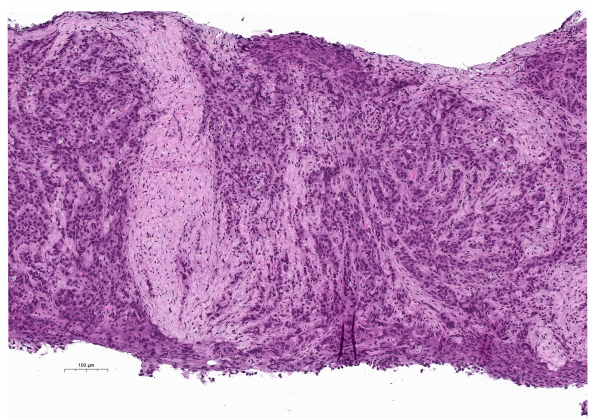
Fig. 2. Non lymphoid malignant proliferation in the left supr- aclavicular lymph node (hematoxylin eosin). The picture cor- responds to lymphonodular metastasis of an adenocarcinoma. The primary tumour is a large cell neuroendocrine cancer of the prostate dedifferentiated from a known adenocarcinoma.